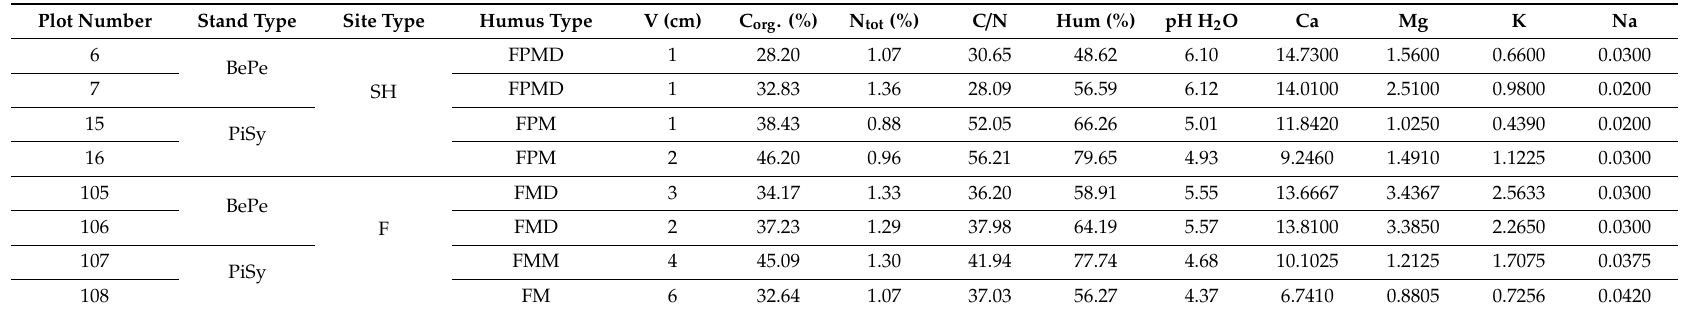
Table A2. Basic characteristics of organic soil layers of sample plots. Abbreviations: BePe— Betula pendula ; PiSy— Pinus sylvestris ; SH—spoil heap; F—forest sites; V—thickness; Corg—organic carbon; Ntot—nitrogen; Hum—humus content, Ca, Mg, K, Na contents (cmol( + ) / kg); FPMD—fresh protomoder; FPM—fresh protomor;